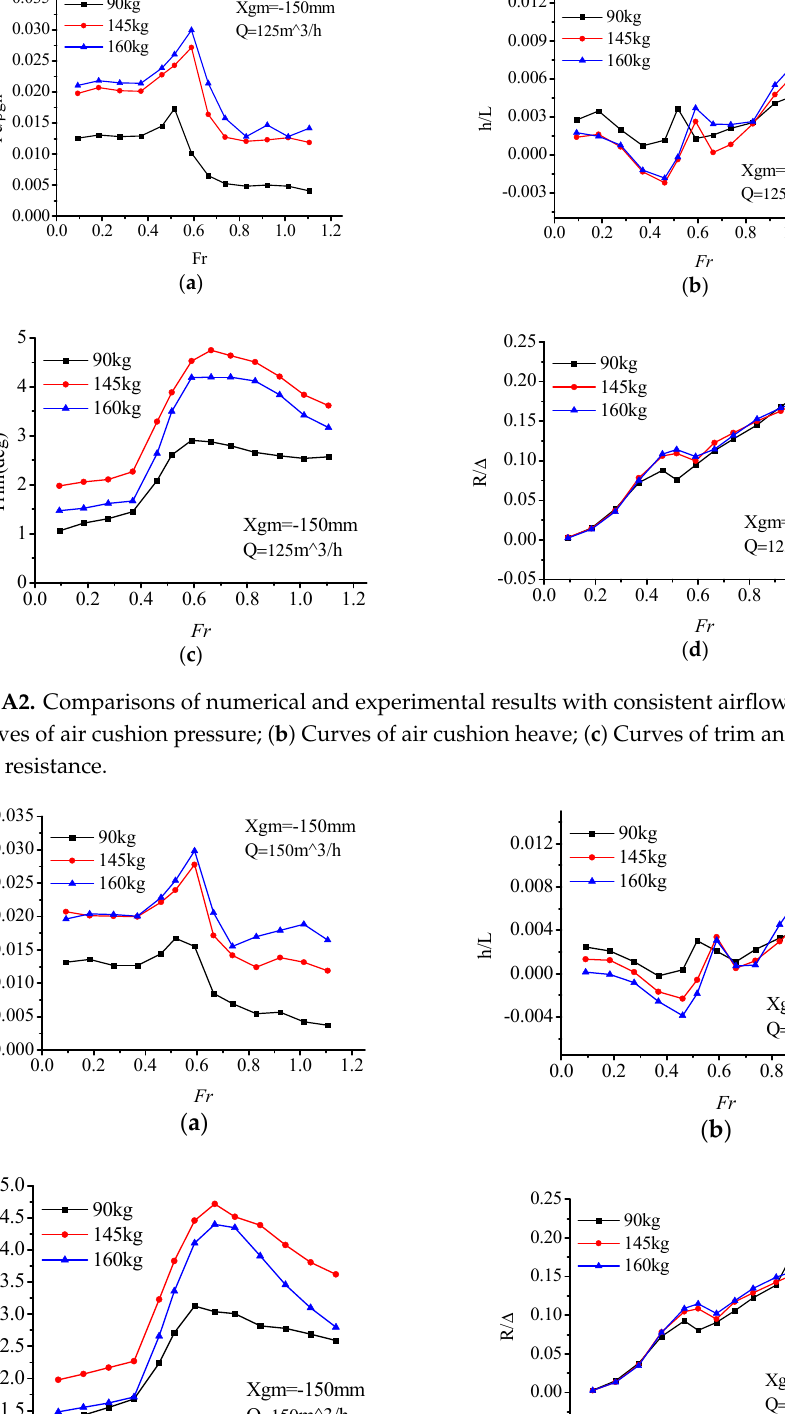
of total resistance.